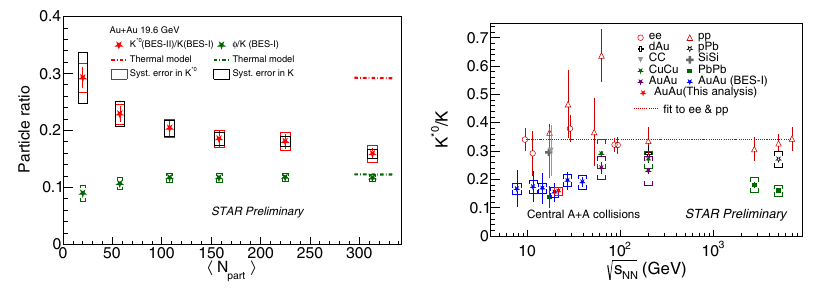
N part along with the thermal ⟨ ⟩